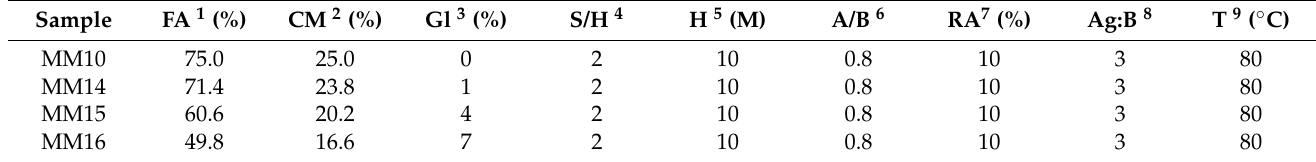
Table 9. Key material ratios of the mortar mixtures—second approach.